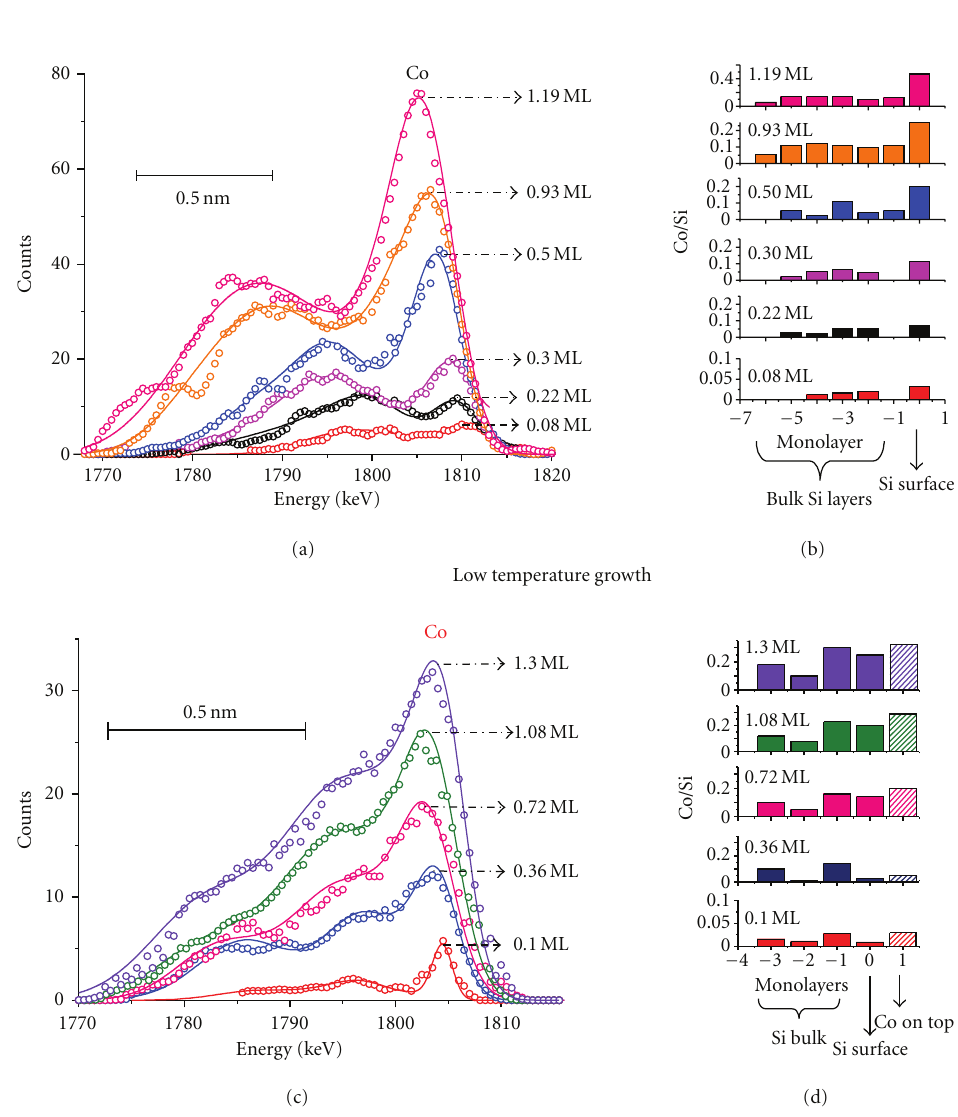
Figure 2: Co on Si (100), low coverage ( ≤ 1.3ML). Panels at the left-hand side: Co edge of HRBS spectra (circles) and RUMP simulations (solid lines). Panels at the right hand side: Co concentrations as determined by the RUMP simulations versus depth (depth scale: monolayers of Si, each 6 . 87 · 10 14 at./cm 2 thick). (a) Co deposition at RT. The peaks between 1800 and 1810 keV are due to backscattering from Co at the surface, the other peaks in the range of 1785–1800 keV due to Co atoms in the Si bulk (subsurface enrichment). (b) Co concentration profiles (Co/Si) in subsequent layers of the sample as obtained from (a) by RUMP simulations. Layer 0 is the topmost Si layer; − 1, − 2, − 3, − 4, and − 5 are subsequent layers in the bulk. Note that the y - axes for 0.08 and 1.19ML have scales di ff erent from others. (c) Co deposition at − 60 ◦ C. The peaks between 1800 and 1805 keV are due to backscattering from Co at the surface. The oscillations in the Co concentration mentioned in the text are clearly visible. (d) Co concentration (Co/Si) in the various Si (100) layers of the Si crystal as derived from (c) by RUMP simulations. Layer 1 (hatched column) corresponds to Co atoms on top of the Si crystal, layer 0 is the first Si layer, and layers − 1, − 2, − 3, and − 4 are subsequent layers in the Si bulk (solid